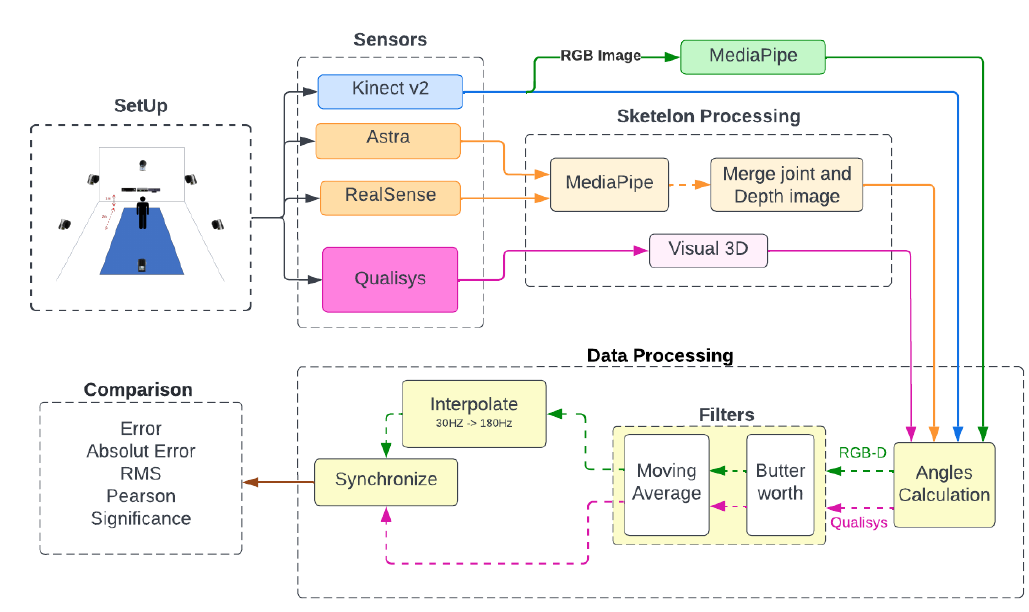
Figure 1. General flowchart of the steps and processes performed in the